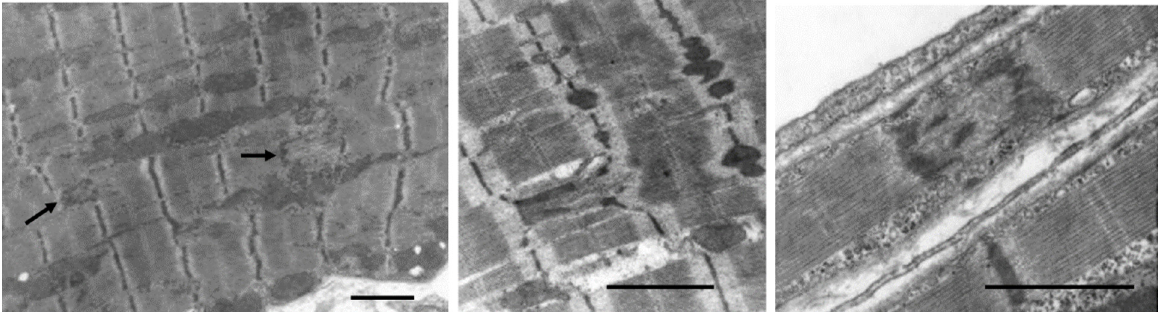
Figure 11. Electron micrographs of RV from a dog with progressive stenosis of the pulmonary artery, RVH, and congestive failure. Z-band expansions (arrow) forming a scaffold for insertion of a new sarcomere within the myofibril and malalignment of myofibril Z-bands. Bar = 2 µ m in